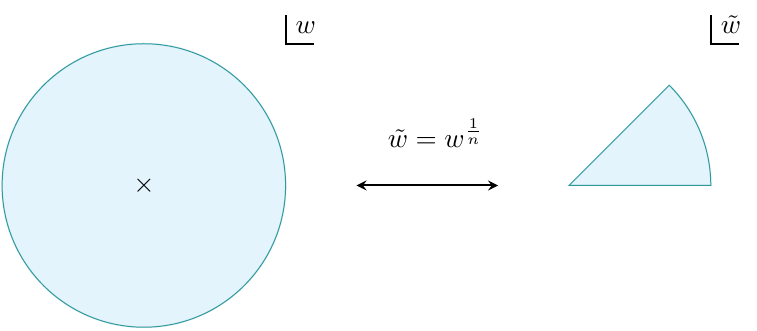
Figure 6. Two ways of describing a conical singularity. In the w = e 2 π β ( σ +i θ ) coordinates, the orbifold M n has an n dependent metric with the inverse temperature β . On the other coordinates 2 π (˜ σ +i˜ θ ) , the geometry is uniformized and its metric realizes an AdS ˜ w = e β temperature β/n